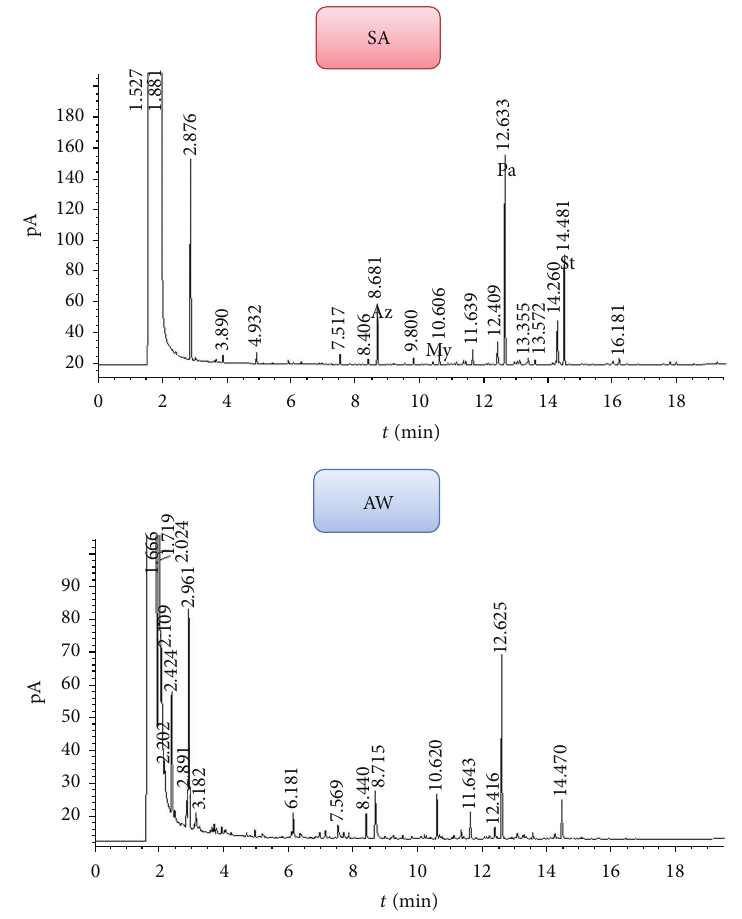
Figure 6: GC chromatogram of “Servilius Appius” (SA) (the integration of the peaks calculated ratios of acids: Pa/St = 1,92; Az/Pa = 0,26; Pa/My = 10,37; Pa—palmitic acid, St—stearic acid, Az—azelaic acid, and My—myristic acid) and “Allegory of Wealth” (AW) (the integration of the peaks calculated ratios of acids: Pa/St = 4,10; Pa/My = 3,92; Az/Pa =